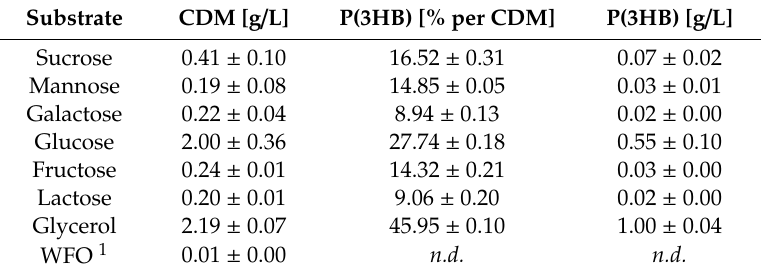
Table 1. Production of PHA on various carbon sources.